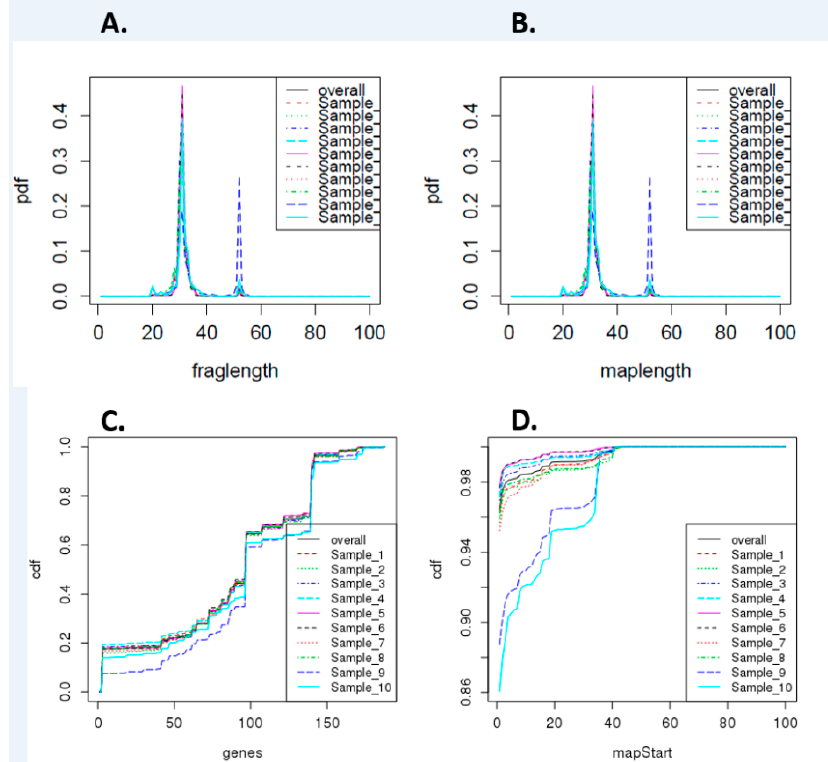
Figure 5. Summary of differentially expressed tRNA fragment data. ( A ) Cumulative density of tRNA fragment length, ( B ) alignment length, ( C ) gene counts, and ( D ) map start position. Samples 1–5 are derived from young donors and 6–10 are old